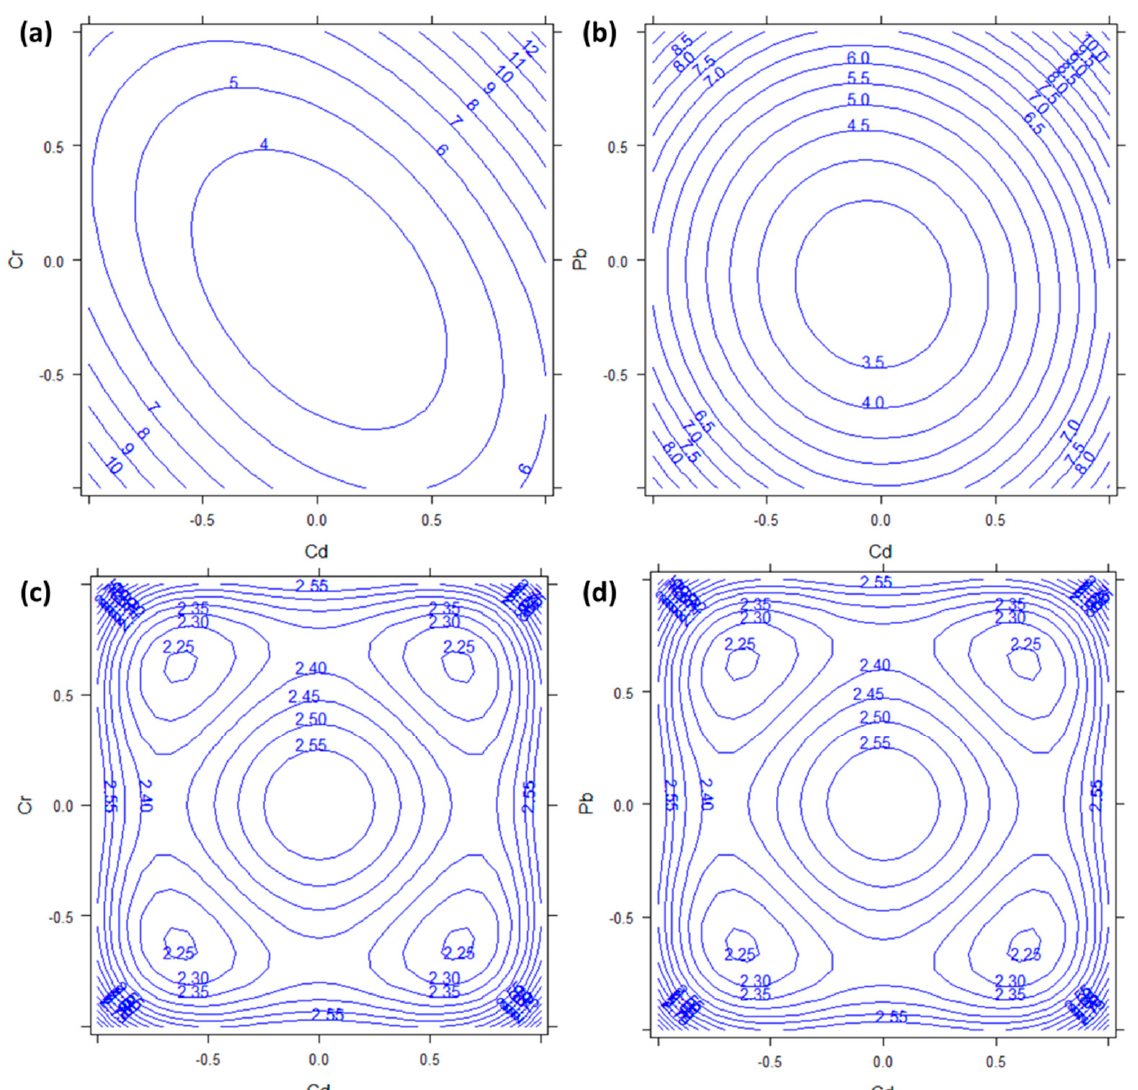
Figure 4. Response surface and semiaplitudes of the 95%confidence intervals for Cu response: ( a ) response surface with Cd and Cr in abscissa and ordinate; ( b ) response surface with Cd and Pb in abscissa and ordinate; ( c ) semiaplitude of the 95% confidence interval with Cd and Cr in abscissa and ordinate; ( d ) semiaplitude of the 95% confidence interval with Cd and Pb in abscissa and ordinate. The third factor, not represented in each plot, has always been kept constant to the 0 level.